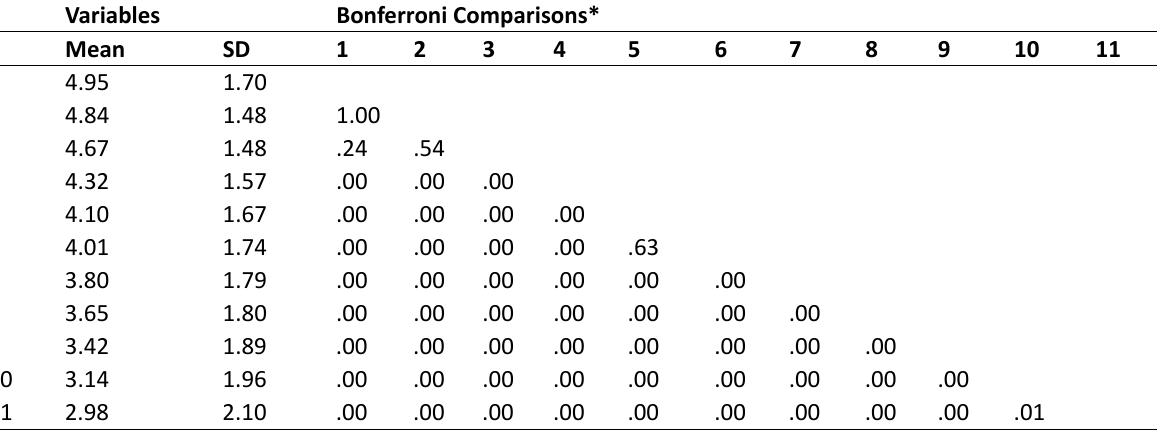
Figure 3). Impacts of the variables of gender, climbing experience, climbing level and chalk density level on climbing willingness are compared with the ANOVA test. The results indicate that within-group variance in terms of the climbing level is statistically significant [F